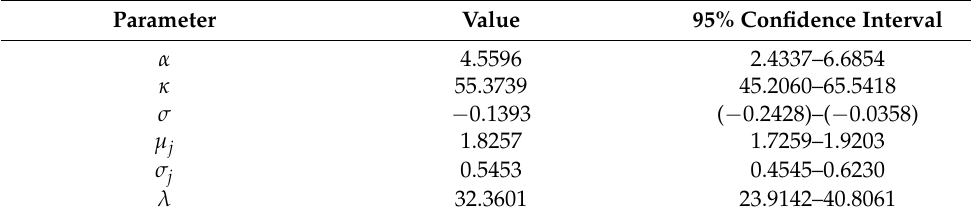
Table 4. Parameters of Stochastic Equation.